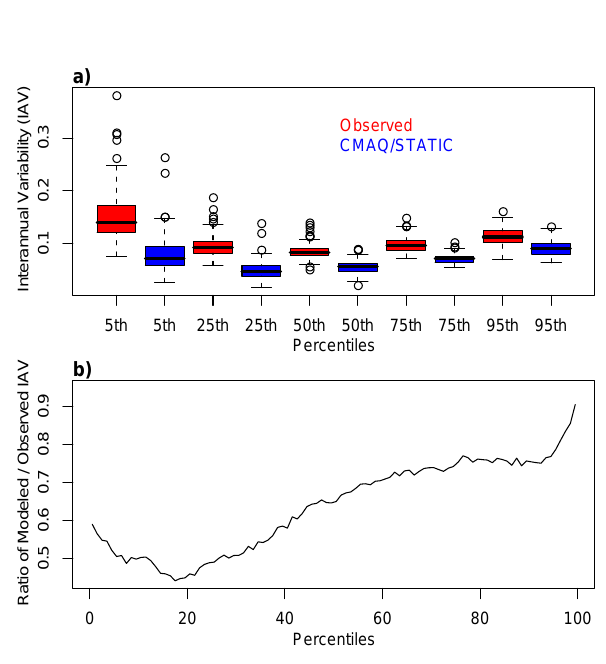
Fig. 4. Interannual variability (IAV) of observed and CMAQ/STATIC 8-h daily maximum ozone concentrations. Details on the calculation of IAV are provided in the text. (a) boxplots of the observed and simulated IAV for the 5th, 25th, 50th, 75th, and 95th percentiles of May–September 8-h daily maximum ozone concentrations; the box plots show the distribution of IAV for a given percentile across the 90 sites considered in the analysis (b) ratio of CMAQ/STATIC IAV to observed IAV vs. percentiles of May–September 8-h daily maximum ozone concentrations; the median IAV ratio across all 90 sites is shown for each